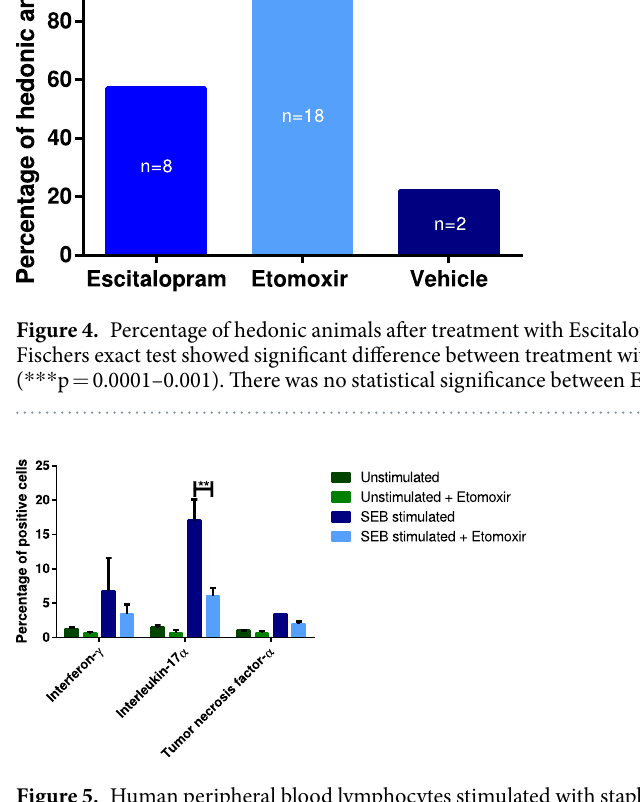
Figure 5. Human peripheral blood lymphocytes stimulated with staphylococcal enterotoxin B (SEB) for 48 h and gated for CD 3 + cells. SEB stimulation activates the immune system. All data are presented as mean ± SEM. The results from the two-way ANOVA (interaction F = 3.576, DF = 6, p = 0.0287; cytokine F = 7.362, DF = 3, p = 0.0082; treatment F = 14,83, DF = 2, p = 0.0002) with a Tukey multiple comparisons post hoc test showed statistical significant difference in percentage of interleukin-17 α positive cells between SEB stimulated cells and SEB stimulated cells receiving Etomoxir ( ** p =